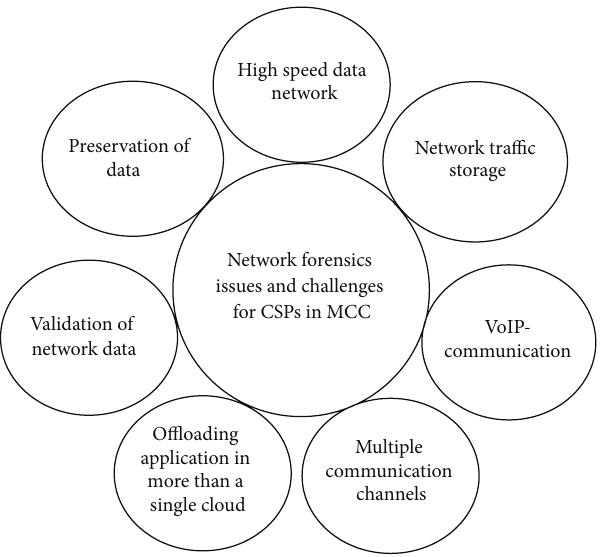
Figure 3: Network forensics: issues and challenges for CSPs in